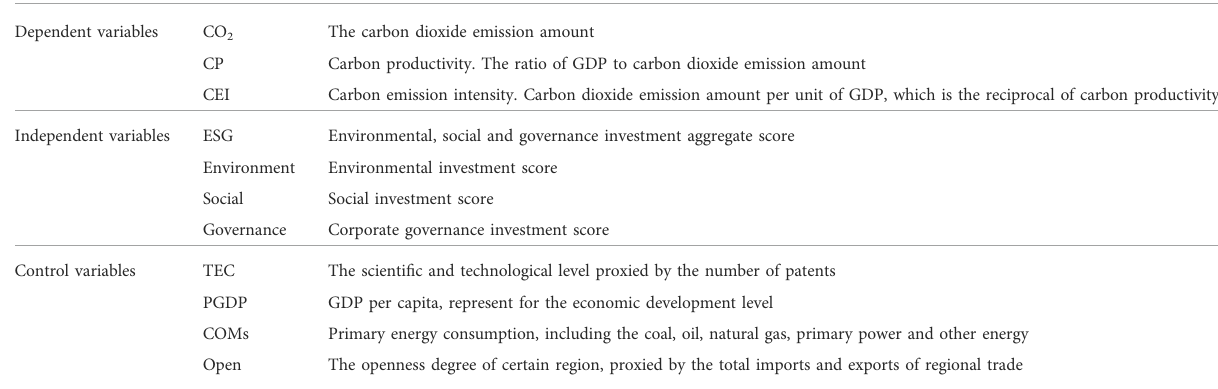
TABLE 1 Variable de fi